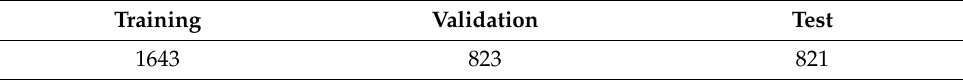
Table 2. Number of images used for training, validation and testing.